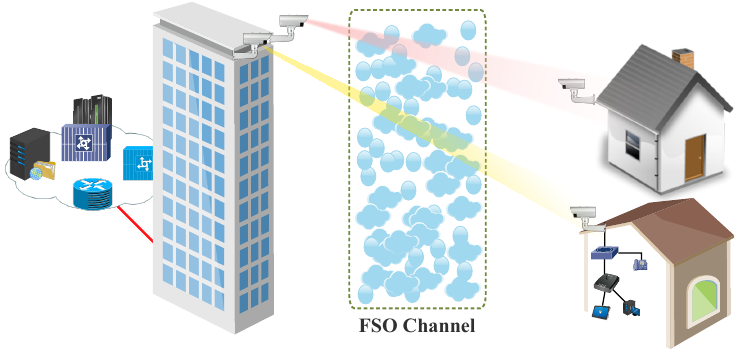
Figure 6. A typical FSO